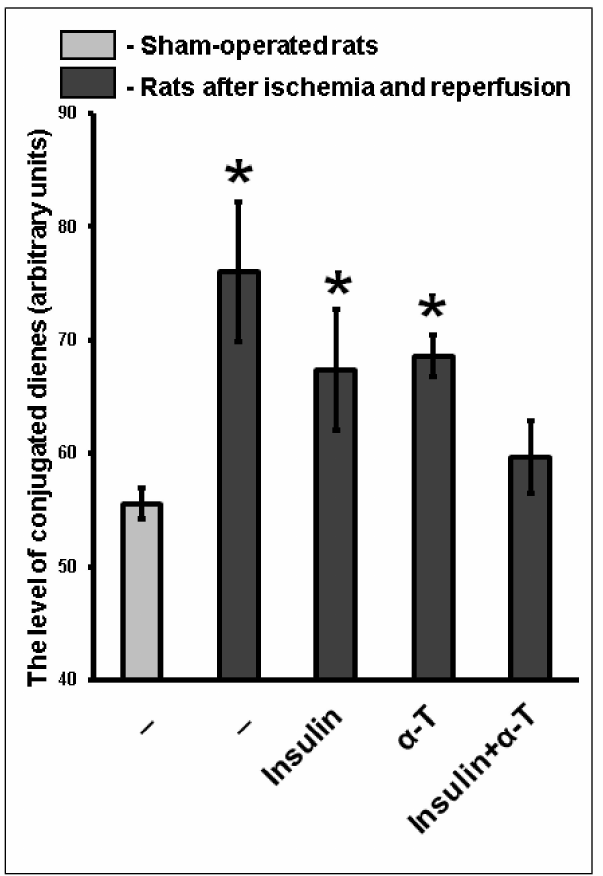
Figure 9. The effect of intranasally administered insulin and orally administered α -T on the level of conjugated dienes in the brain cortex of rats with two-vessel forebrain ischemia followed by reperfu- sion. The data of 5–7 experiments are shown as the means ± SEM. The two-vessel forebrain ischemia was induced by ligation of carotid arteries for 20 min and hypotension followed by reperfusion for 1 h. Insulin was administered intranasally at a dose of 0.25 IU/rat, while α -T was given orally at a dose of 50 mg/kg. *—The differences are significant according to Student’s t -test as compared to control values in the brain cortex of sham-operated rats, p <